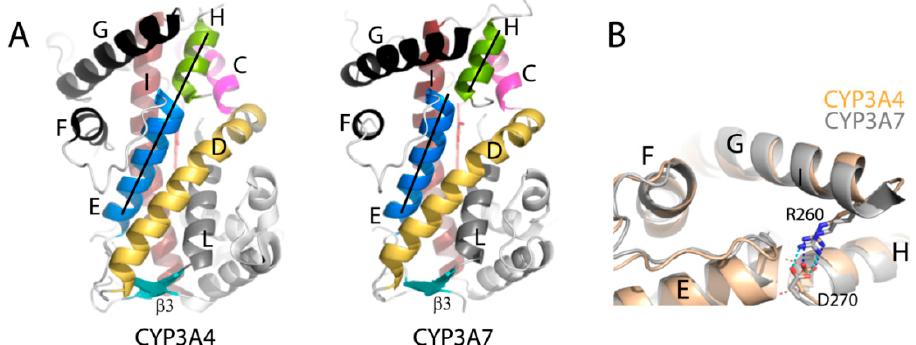
Figure 7. ( A ) Side views of CYP3A4 (5vcc) and CYP3A7 (molecule A) show relative positioning of the E- and H-helices. ( B ) Contact site between the F-, G-, E-, and H-helices. In CYP3A4, two hydro- gen bonds are formed between the main chain atoms of the T187/F271 and A188/L272 pairs (de- picted as red dotted lines), which together with the R260-D270 salt bridge could mediate communi- cation between the helices. In CYP3A7, the E-helix shift leads to H-bond disruption/elongation and decreases the E/H-helix contact area by half.